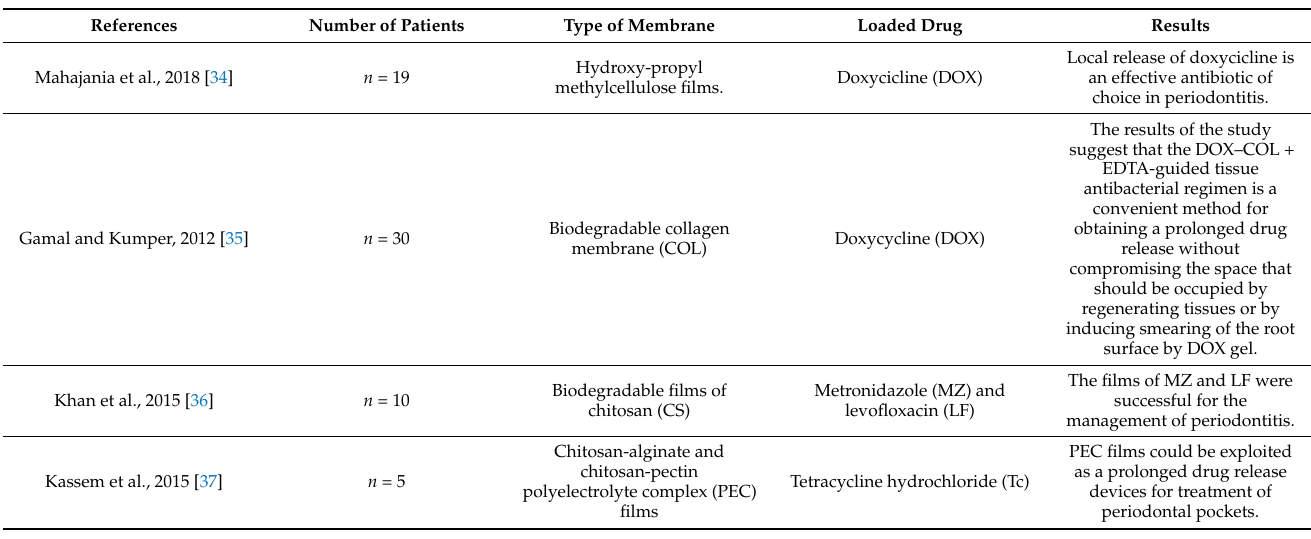
Table 2. Human studies included in the